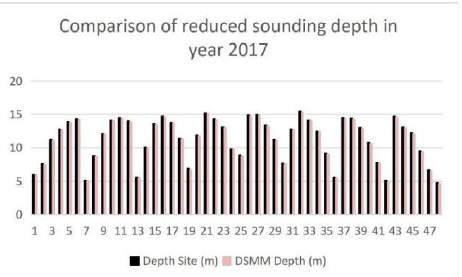
Figure 29. The comparison between depth relative to the on-site and DSMM tide gauge in 2017 Table 6. RMSD between the reduced sounding depth relative to on-site and DSMM tide gauge in 2017